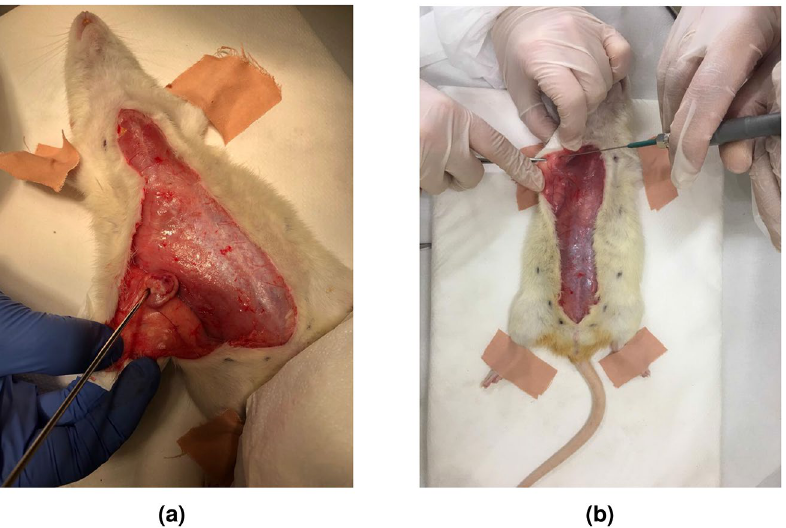
Figure 5. Measurement of samples during in vivo dielectric property and S-parameter response collection: ( a ) rat breast tumor and ( b ) rat breast healthy